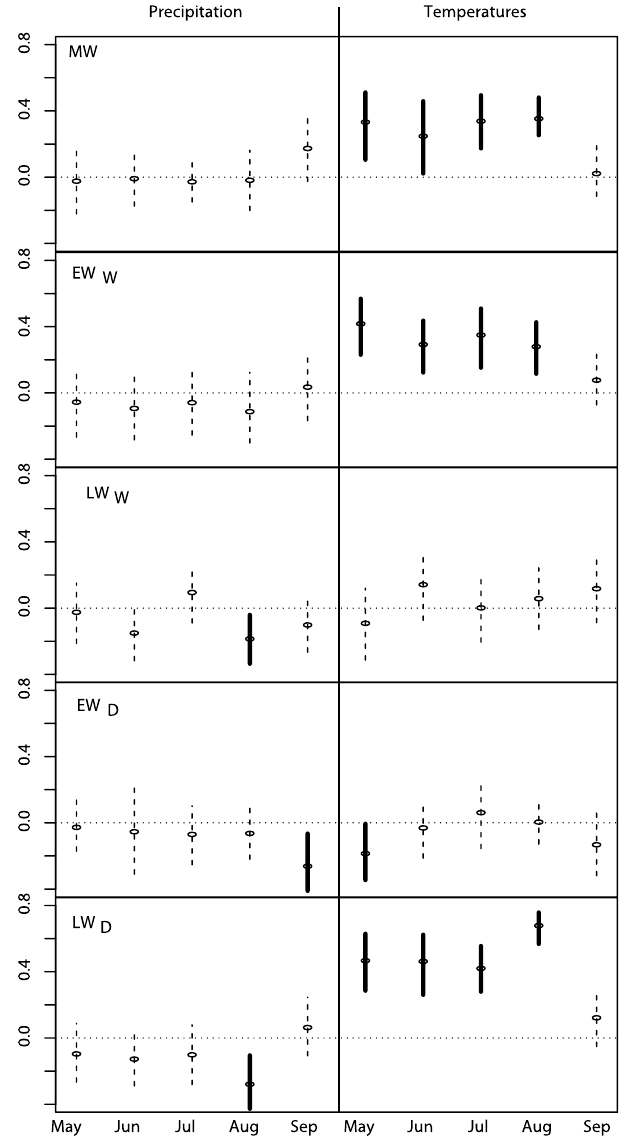
Figure 2. Pearson correlation coefficients for MW (top) and the four variables used in the calculation of MW : EW w , LW w , EW D and LW D . Relationships with precipitation and surface temperatures are shown in the left and right panels, respectively. Bold lines indicate significant ( p < 0.05) relationships. All correlations are calculated on the 1901–2000 period (N = 100) after averaging both climatic and tree ring data from the 48 sites used in this